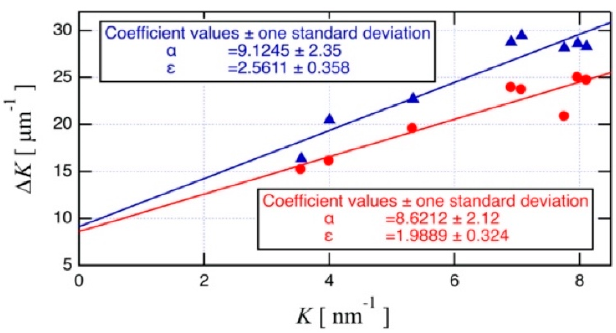
Figure 12. Williamson–Hall plot for the plasma-treated powder (red circles) and the raw powder (blue triangles).